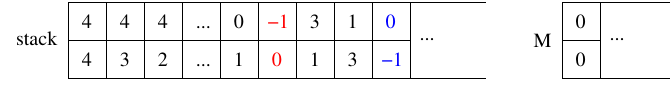
Figure 5. The explicit stack and the solution array in the naive labeling